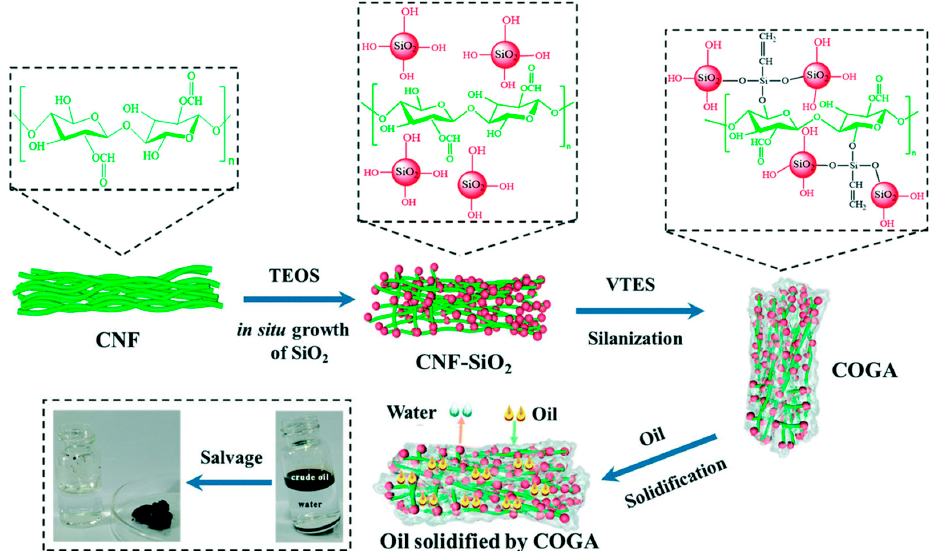
Figure 5. Schematic diagram of the PSOGs 61 preparation and the gelation mechanism for crude oil [80]: A 3D network structure was firstly constructed by the cellulose nanofibril (CNF), and then SiO2 nanoparticles prepared in the mixture of tetraethyl orthosilicate (TEOS), ammonia, and ethanol were introduced on CNF by in situ growth to form CNF-SiO2. Vinyl triethoxy silane (VTES) was used for hydrophobic modification of CNF-SiO2 through a silanization reaction to form CNF-based oil gelling agent (COGA); The COGA was used to solidify the oil layer and the solidified oil was removed from the oil/water mixture.